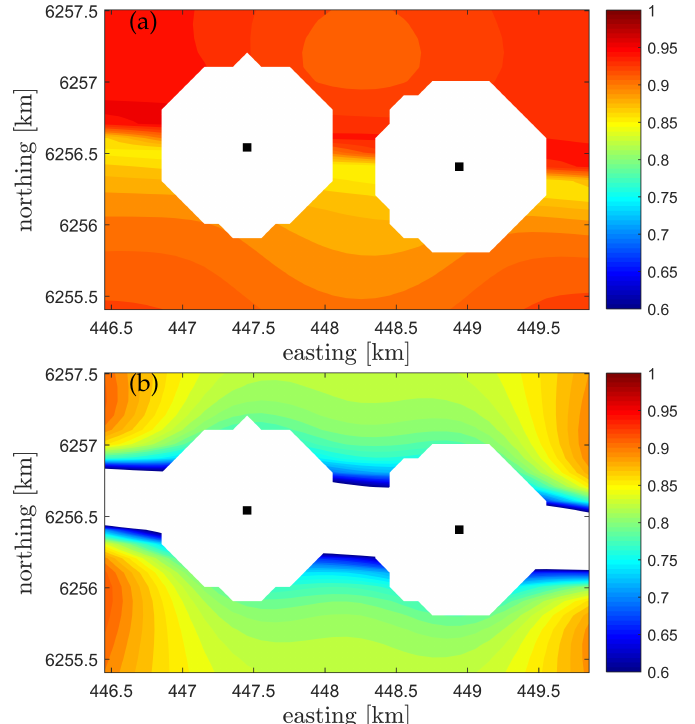
Figure 12. Spatial variation of velocity-variance biases of the dual-Doppler scanning system (lidars in solid rectangles) with respect to the velocity-variance measured at each point for a height of 100 m for a 90 ◦ wind. Turbulence is characterized by Γ = 3 and z R / L = 0.25. Frame ( a ) shows the bias for the u -velocity component, i.e., σ 2 u / σ 2 u , and ( b ) that for the v -velocity component, i.e., σ 2 v ws s